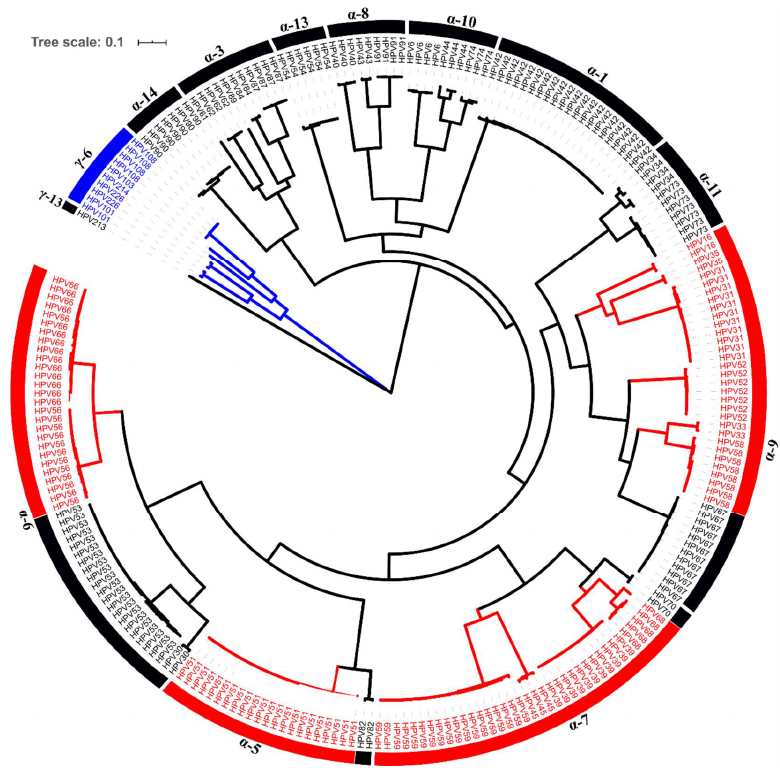
Figure 2. Phylogenetic tree of 243 HPV isolates. The maximum likelihood tree was constructed using RAxML based on complete HPV genomes. High-risk HPV types are shown in red. Gamma-6 species are colored in blue.